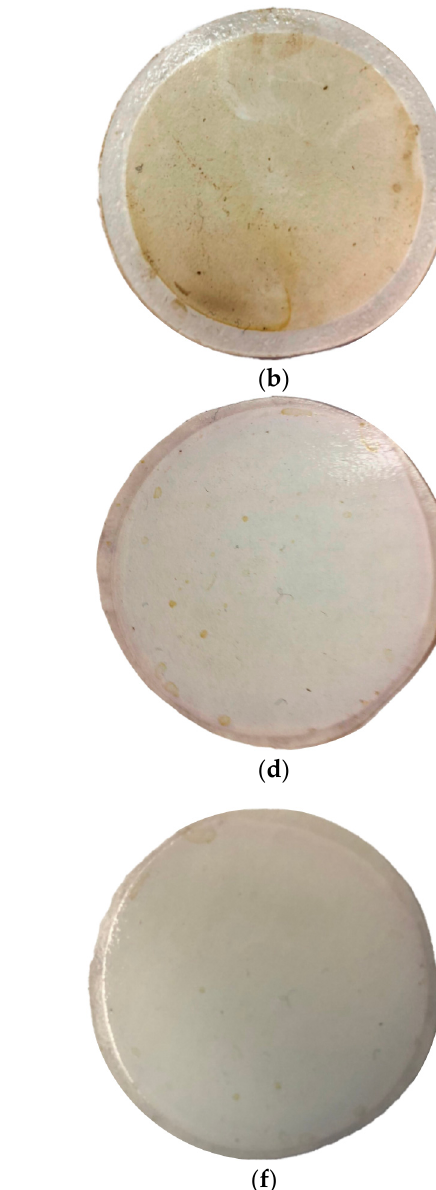
Figure 3. SEM images of cross sections of initial membranes: ( a ) MDK-3; ( b ) PDecMS; ( c ) PHeptMS.